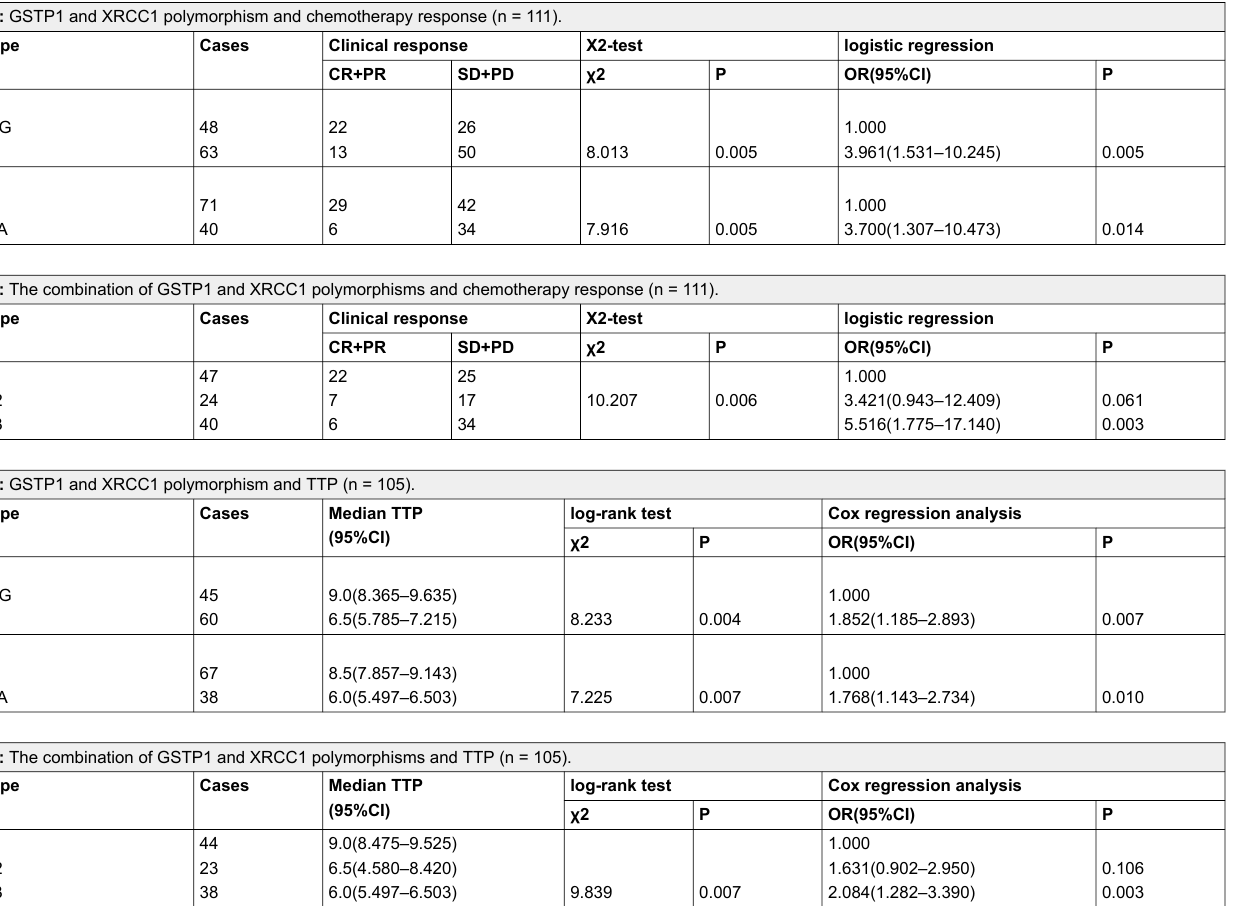
Table 2: GSTP1 and XRCC1 polymorphism and chemotherapy response (n = 111).